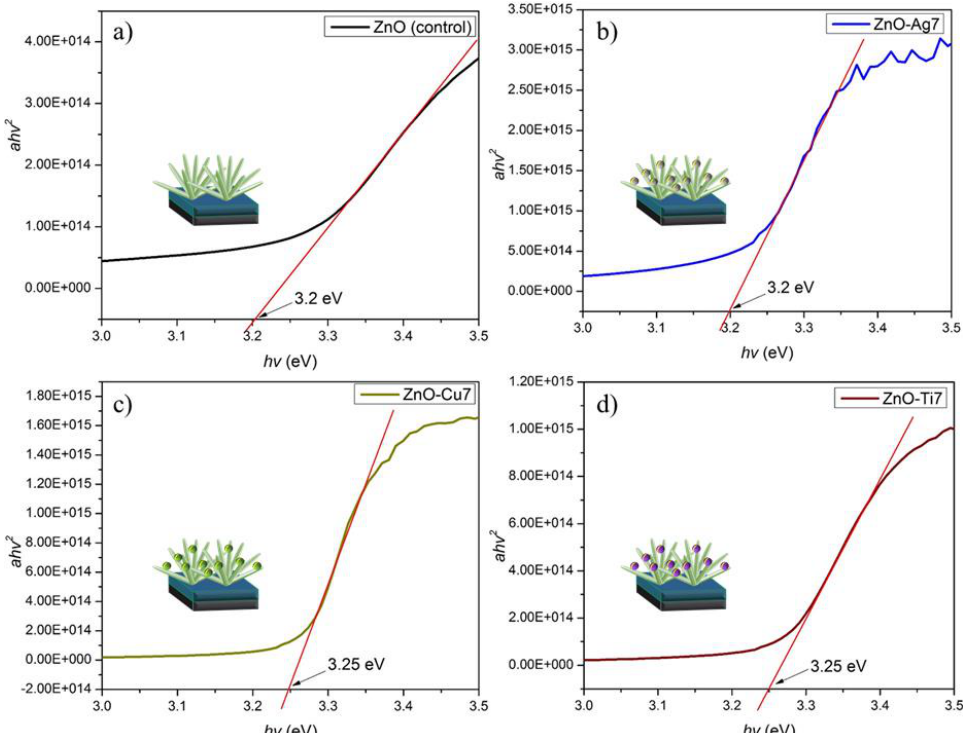
Figure 4. Band gap energies of ( a ) ZnO NFs (control), ( b ) ZnO − Ag7, ( c ) ZnO − Cu7 and ( d ) ZnO − Ti7.